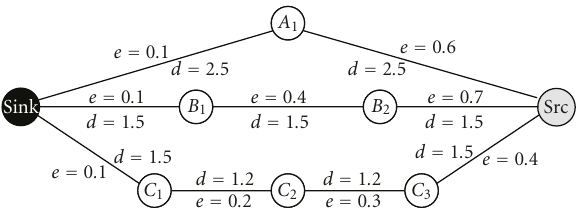
Figure 2: A simple topology with three